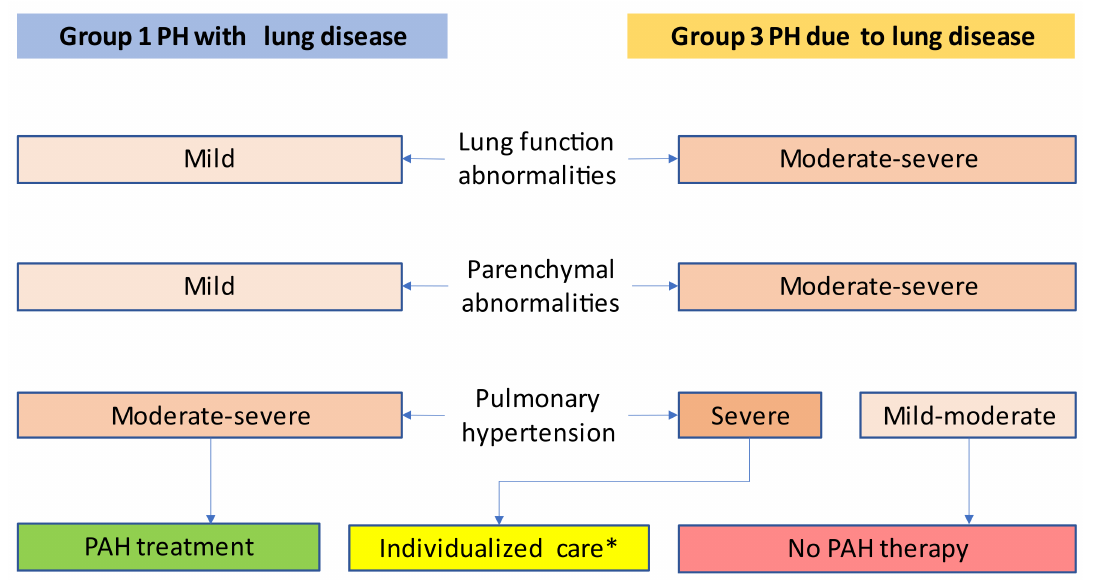
Figure 1. Therapeutic consequences derived from decisions between group 1 PH vs. group 3 PH and severe vs. non-severe pulmonary hypertension. * Therapy decision reserved to expert centers for both chronic lung diseases and pulmonary hypertension. Adapted from Nathan et al.